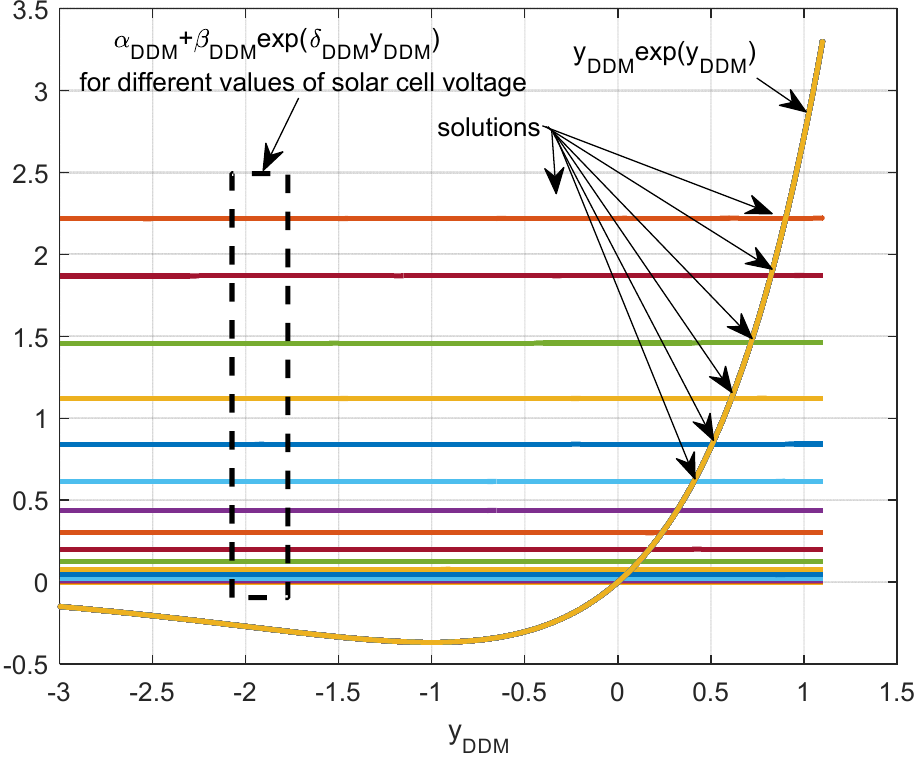
Figure 2. Visualization of α DDM + β DDM e δ DDM y DDM and y DDM e y DDM